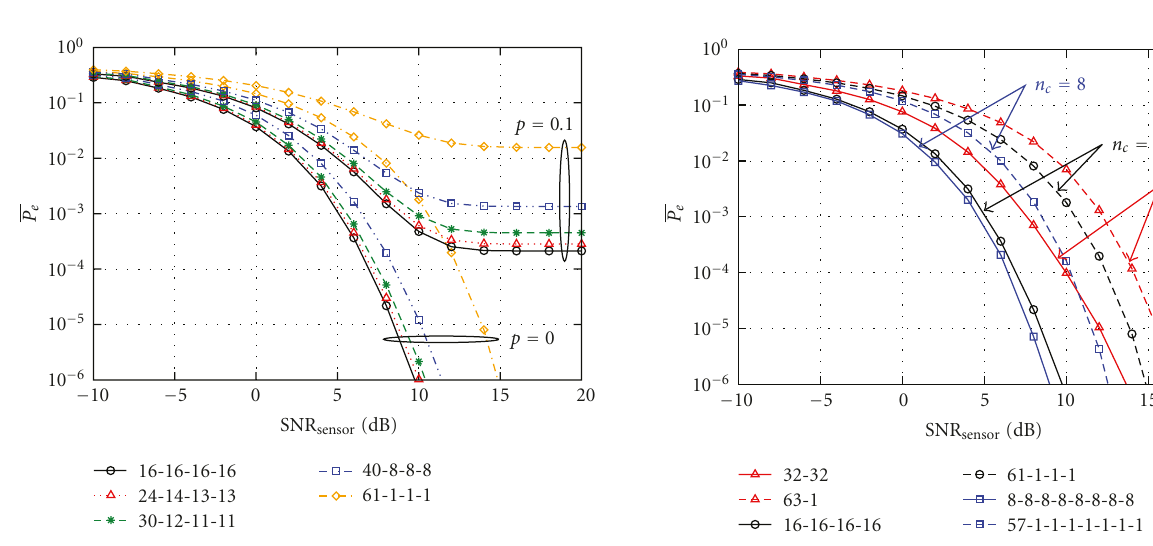
Figure 9: P e , as a function of the SNR, in a scenario with the IEEE 802.15.4 MAC protocol and ideal communication